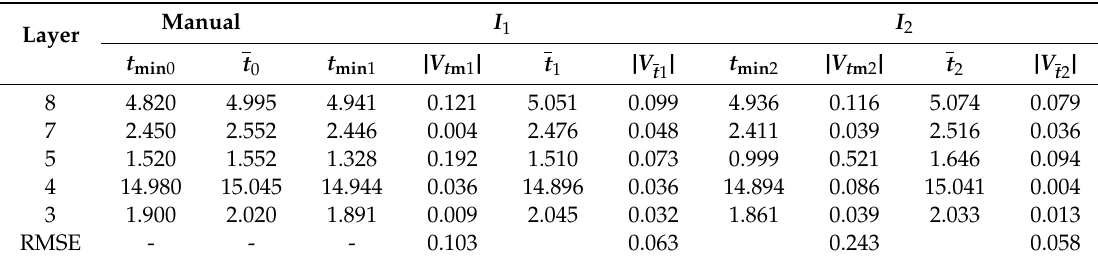
Table 2. Thickness measurement results for I 1 and I 2 . (unit: mm).